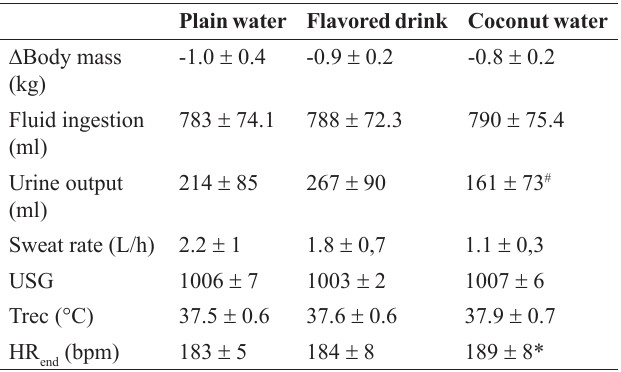
Table 3. Change in body mass, total fluid ingestion, urine output, urine specific gravity (USG), rectal temperature (T end of the exercise capacity test in the heat.